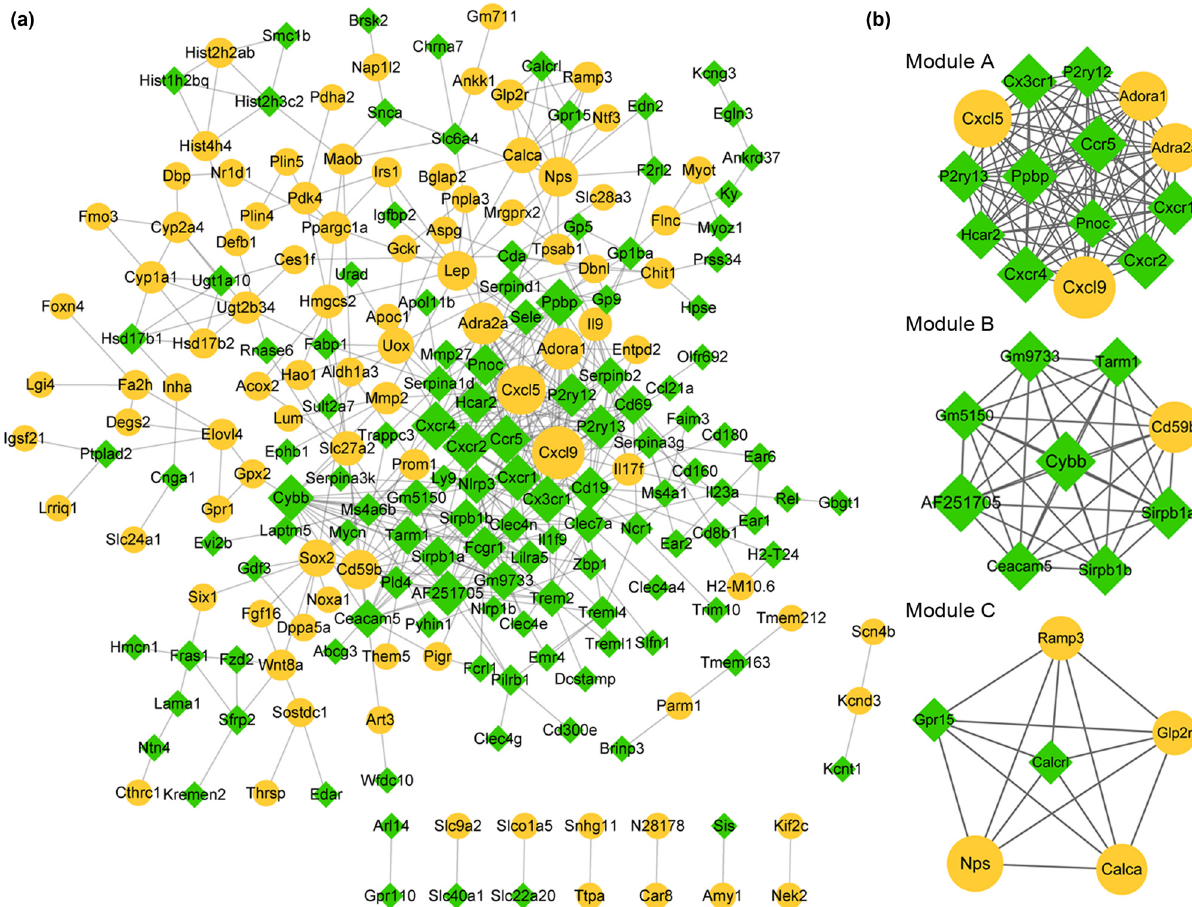
Figure 3: The PPI network of di ff erent expressed genes ( DEGs ) . ( a ) and ( b ) The PPI network and three sub - modules of DEGs, respectively. The yellow circular node represents upregulated genes; the green prismatic node represents downregulated